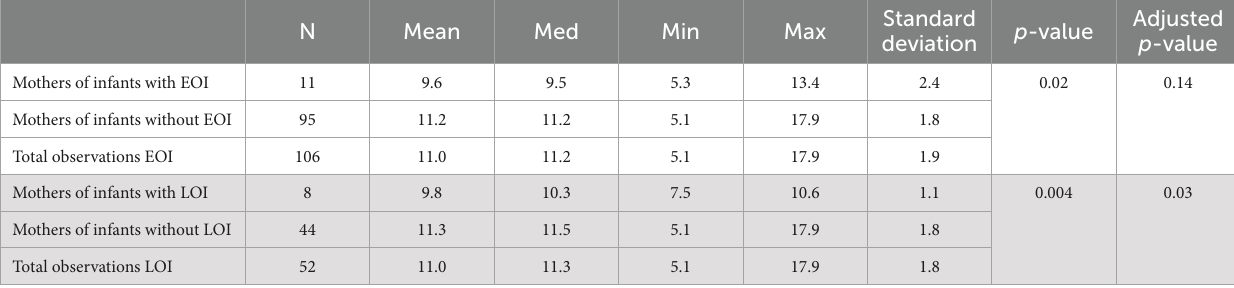
TABLE 4 Maternal level of hemoglobin (g/dl) of mothers of infants with neonatal